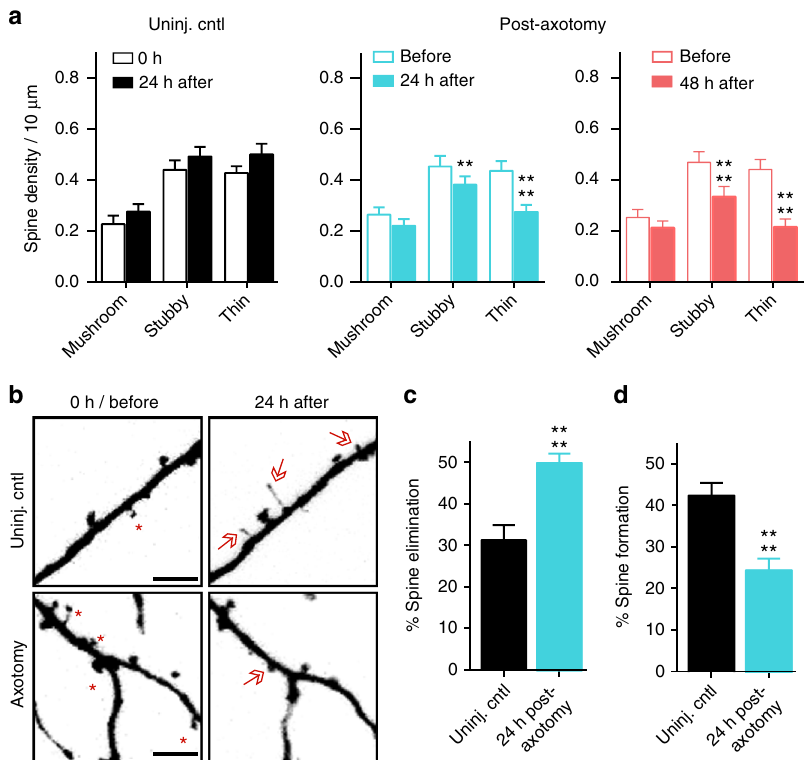
Fig. 2 Analysis of spine types lost and percentages of spines formed and eliminated after axotomy. a Quanti fi cation of stubby, mushroom, and thin spine densities before axotomy, 24 h post-axotomy, 48 h post-axotomy, and in uninjured control chambers. Uninjured controls and axotomized samples were imaged beginning at 13 DIV (labeled “ 0 h ” or “ before ” , respectively). Uninj. cntl: n = 20 dendrites; 5 neurons; 3 chambers over 3 experiments; #spines/TDL: 315/2698 µ m (0 h), 388/2737 µ m (24 h after). Axot.: n = 26 dendrites; 5 neurons; #spines/TDL: 405/3569 µ m (before), 274/2998 µ m (24 h after), and 229/2821 µ m (48 h after). 3 chambers over 3 experiments. Repeated-measure two-way analysis of variance (ANOVA), Bonferroni post hoc test. b Representative images of dendritic segments from uninjured control and axotomized chambers at 0 h or before axotomy, respectively, and 24 h after. Asterisks indicate spines eliminated; arrows indicate formation of new spines. Scale bars , 5 µ m. c , d Bar graphs represent percentage of spines eliminated c and newly formed d 24 h post-axotomy and in age-matched uninjured control chambers. Uninj. cntl: n = 28 dendrites; 6 neurons; #spines eliminated: 92; #spines formed: 177; TDL (0 h, 24 h after): 3147, 3148 µ m. Axot: n = 35 dendrites; 6 neurons; #spines eliminated: 208; #spines formed: 75; TDL (before, 24 h after): 4290, 3865 µ m. 3 chambers over 3 experiments. Unpaired two-tailed t -test. ** p < 0.01, **** p < 0.0001. Error bars ,